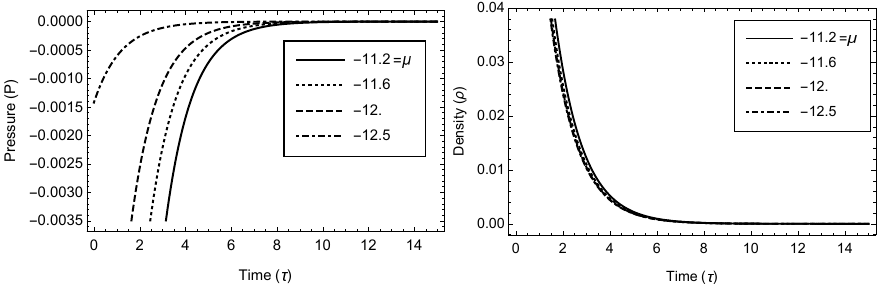
Figure 1. Variation of the pressure and density w.r.t. time (Case 3.1). Here, we considered the following parametric values: k 1 = 0.13, k 3 = 0.1, and m = 0.5, which will also be followed in all other plots.